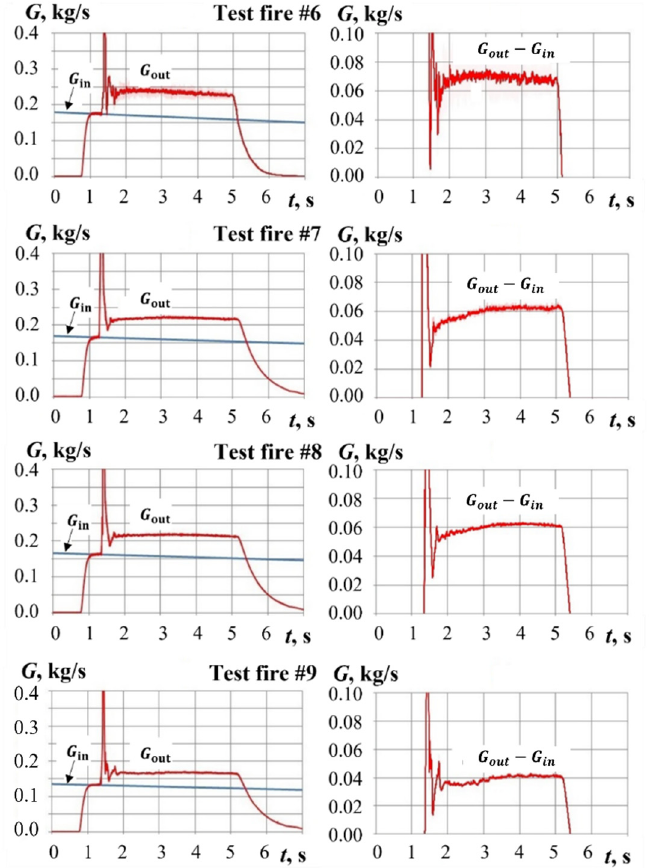
Figure 14. Calculated mass flow rates G in ( t ), G out ( t ), and G out ( t ) − G in ( t ) in test fires #6 to #9. In test fires #6 to #9, PP sample ignition and combustion in air flow was